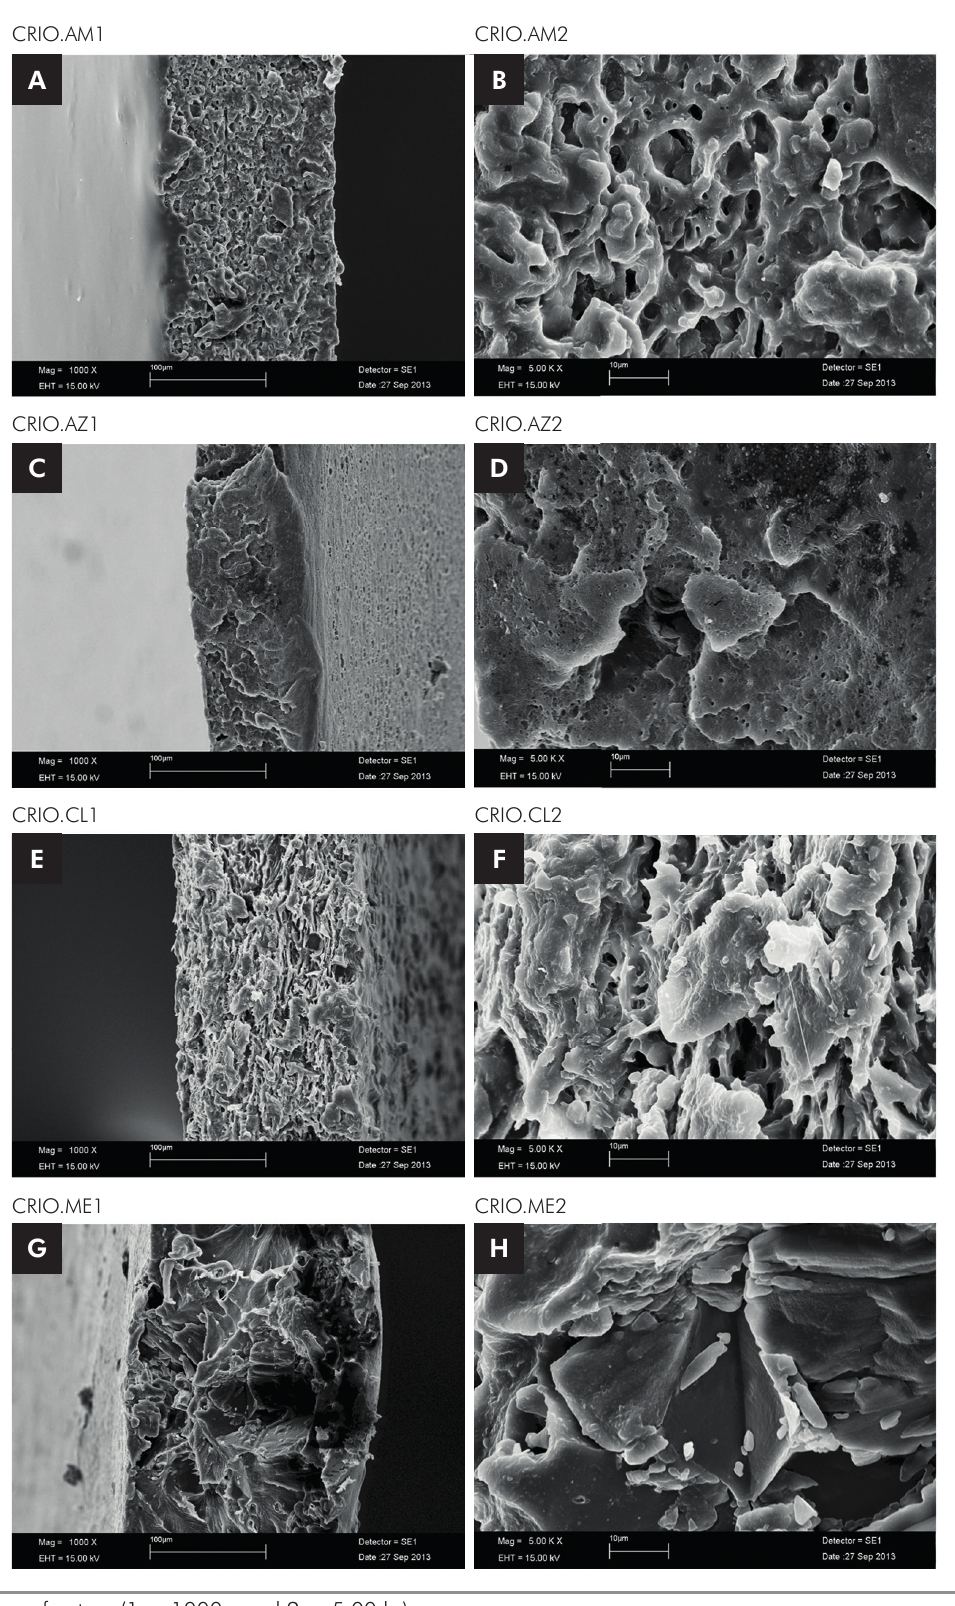
Figure 7. Freeze-fracture (1 = 1000 x and 2 = 5.00 kx).